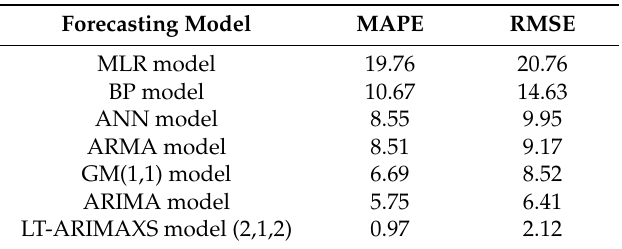
Table 4. The performance monitoring of the forecasting model